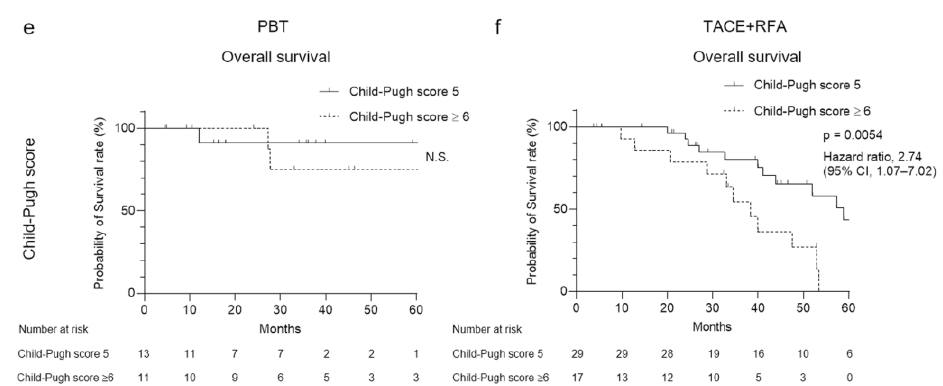
Figure 4. Changes in ALBI score and overall survival classified by hepatic reserve after PBT or TACE + RFA treatment. ( a , b ) Changes in ALBI score after PBT and TACE + RFA treatment classified by mALBI grade in second- and third-line treatments of HCC. Each value represents the box and whisker plot (highest, third quartile, median, first quartile and lowest value). ( c – f ) Overall survival after PBT and TACE + RFA treatment classified by ( c , d ) mALBI grade and ( e , f ) Child–Pugh score. ( a , b ) Tukey–Kramer post-hoc test. * p < 0.05, N.S., not significant.